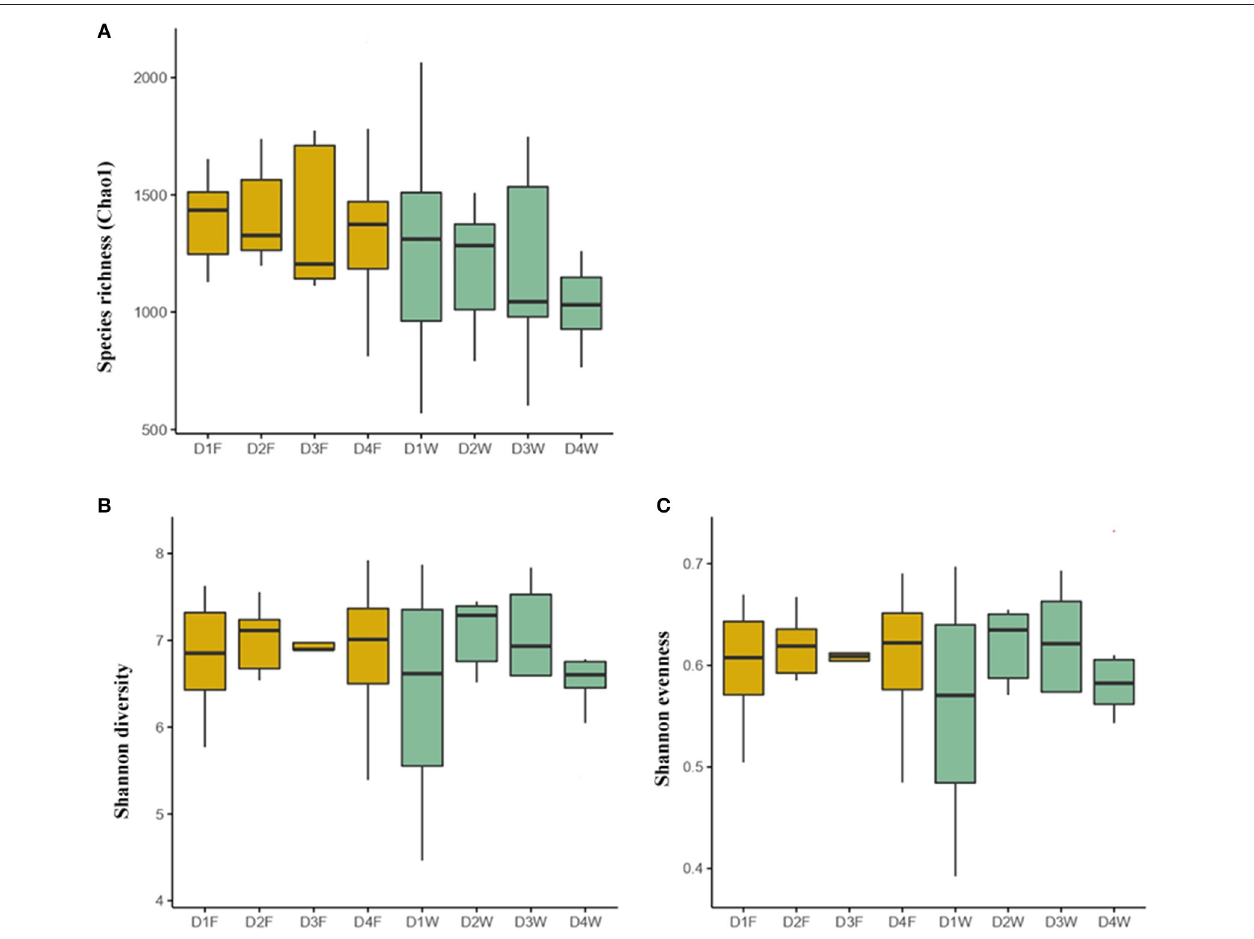
FIGURE 1 | The bacterial community indices in the fruiting body and wood of different decay classes. (A) Species richness, (B) Shannon diversity, and (C) Shannon evenness. The outliers were removed. D1F and D1W refer to the fruiting body and wood from the first decay class; D2F and D2W refer to the fruiting body and wood from the second decay class; D3F and D3W refer to the fruiting body and wood from the third decay class; D4F and D4W refer to the fruiting body and wood from the fourth decay